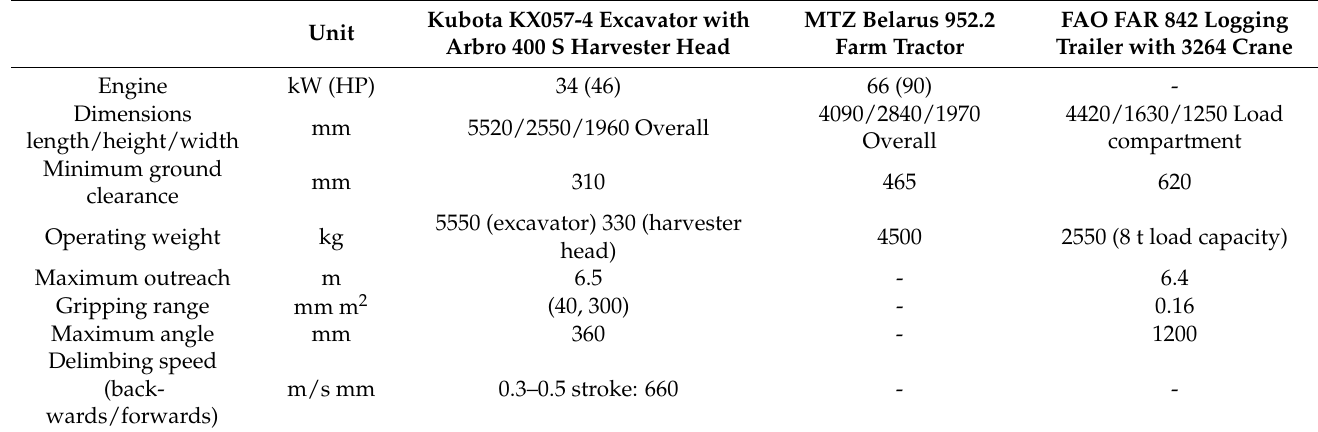
Table 1. Characteristics of the timber harvesting